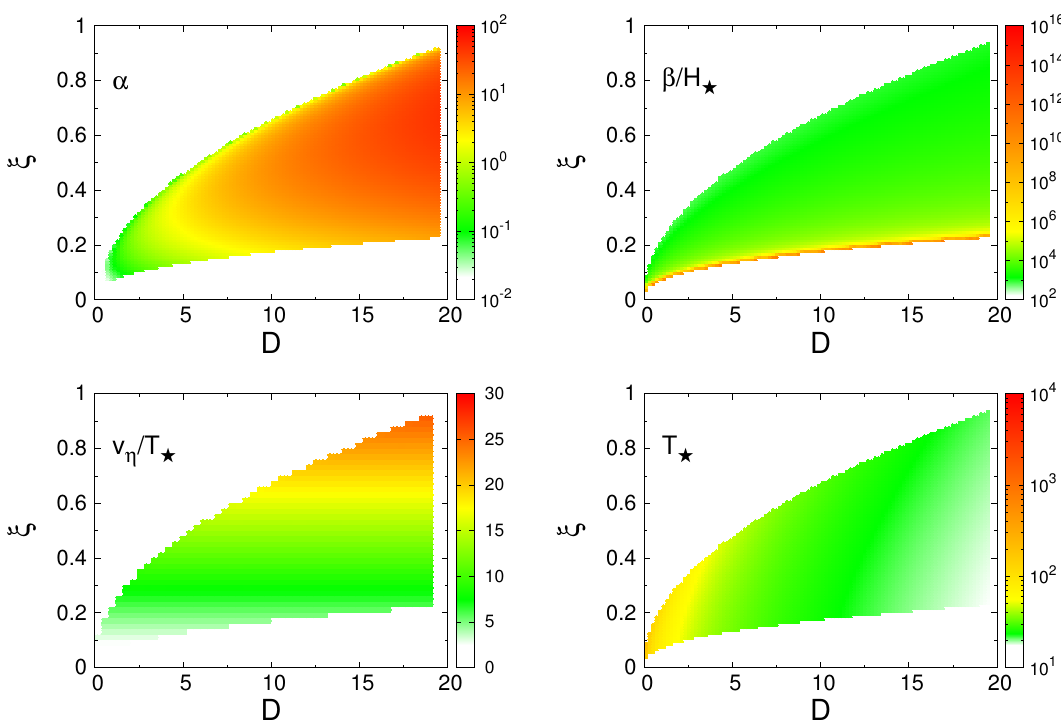
Figure 2 . The parameters α , β/H , v η /T ? , and T ? for the Scalar Quartic Model with λ = 0 . 1 .